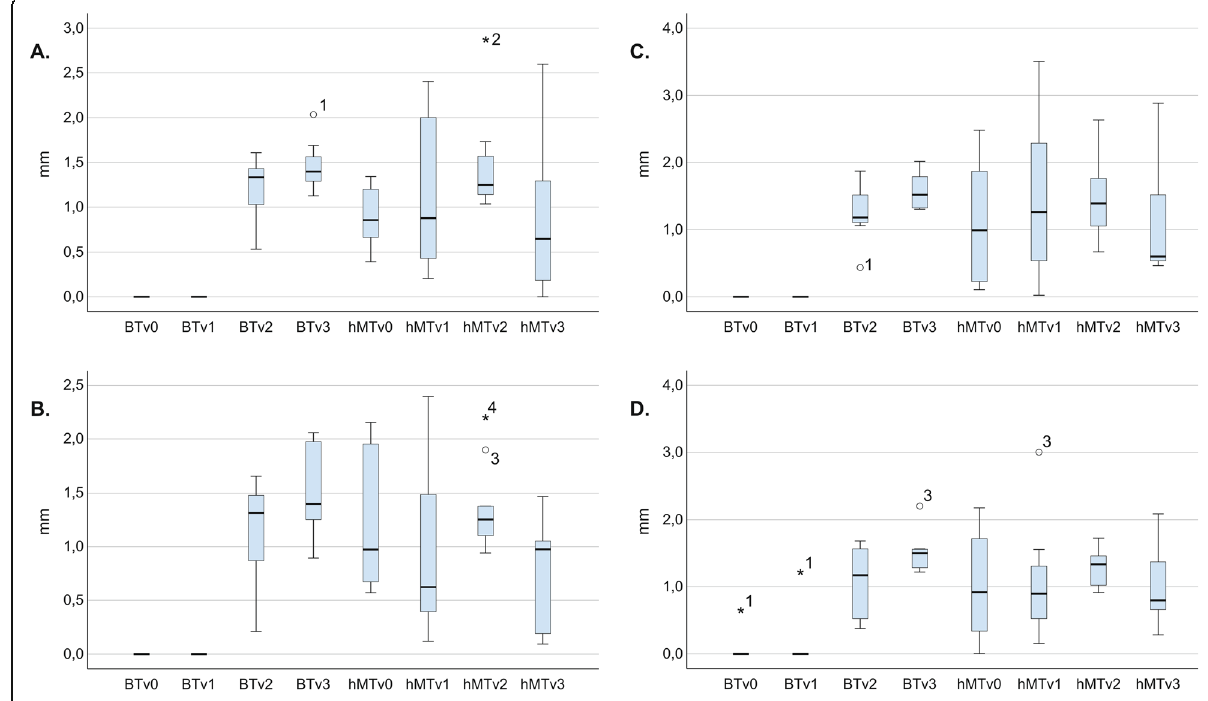
Fig. 3 Boxplots indicating hMT and hBT values in different groups. a EB. b P. c EB + rhBMP-2. d P +